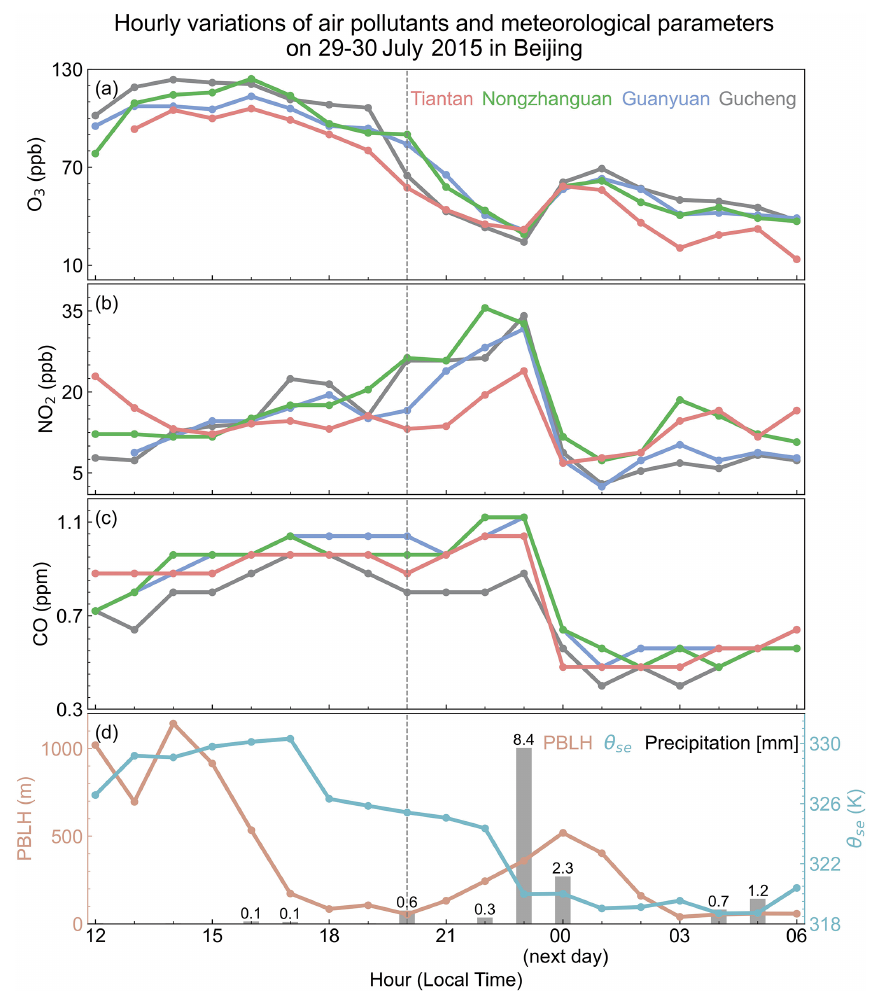
Figure 8. Hourly variations in air pollutants and meteorological parameters at four sites during a Beijing NOE event on 29–30 July 2015 that was induced by a convective storm. Panels (a) , (b) , and (c) show the evolution of ozone, NO 2 , and CO, respectively. Panel (d) shows the evolution of the PBLH, equivalent potential temperature ( θ se ), and precipitation from the ERA5 dataset. The vertical dashed line marks the start of